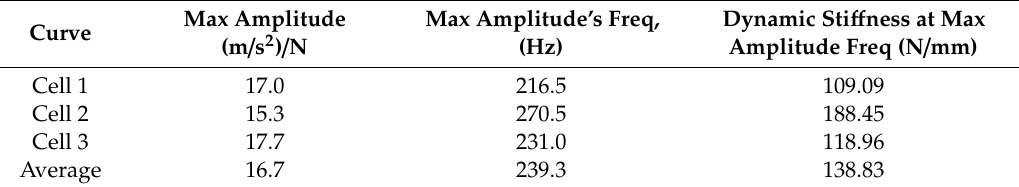
Table 3. FRF analysis of cell after